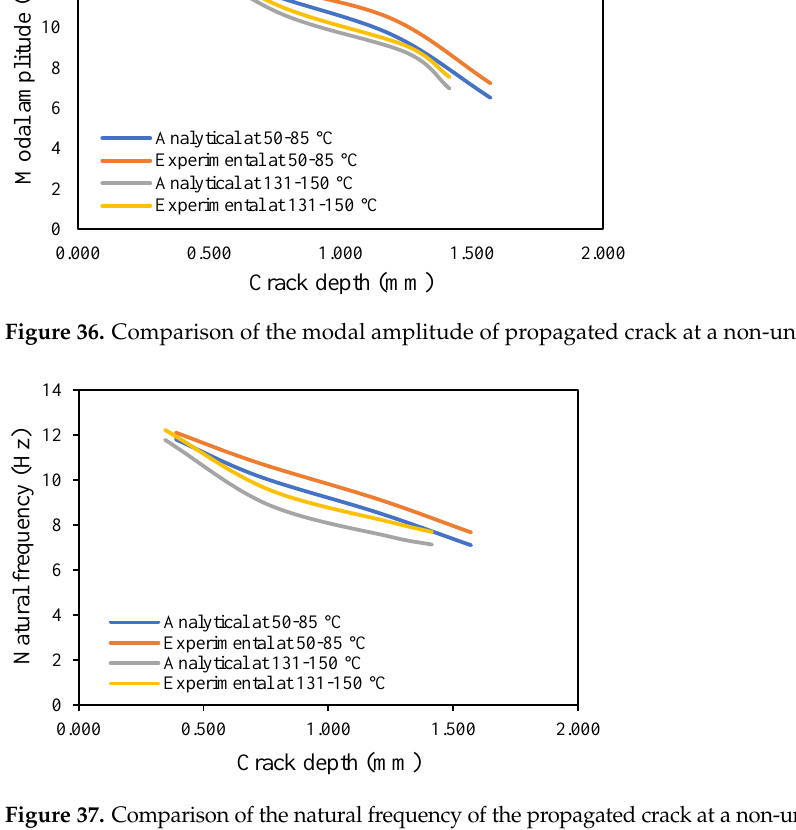
Figure 37. Comparison of the natural frequency of the propagated crack at a non-uniform temperature.